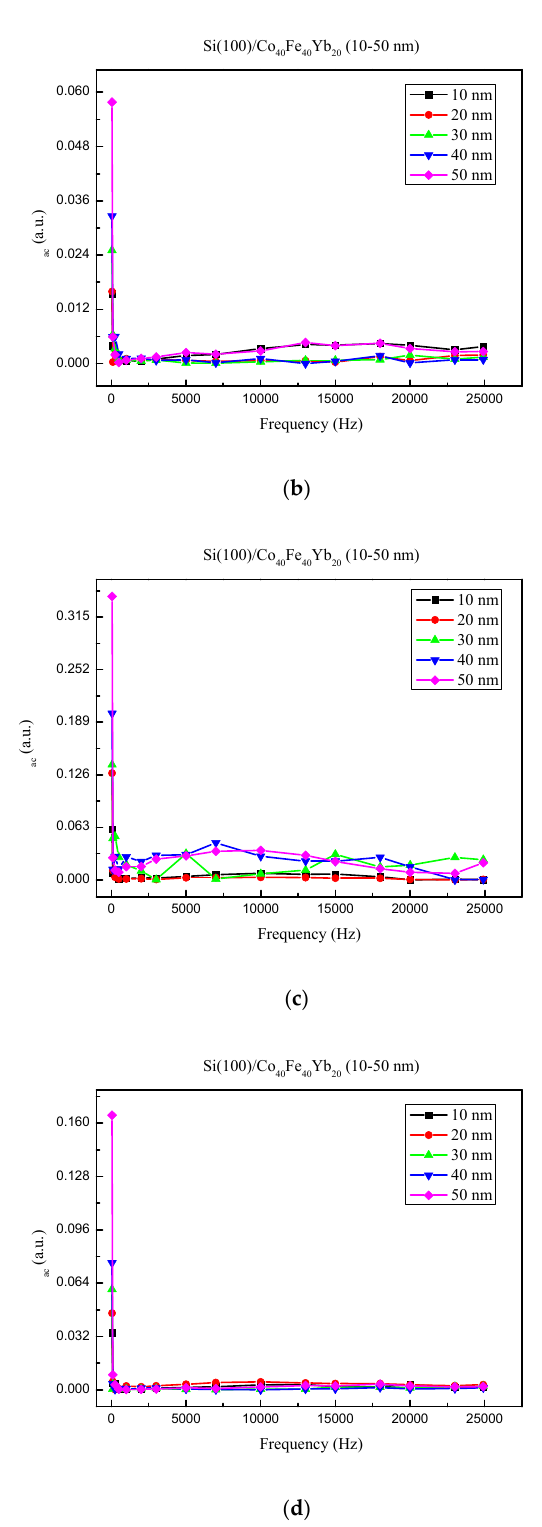
Figure 8. The frequency dependence of alternate-current magnetic susceptibility ( χ ac ) from 50 to 25,000 Hz. ( a ) As-deposited, ( b ) post-annealing at 100 ◦ C, ( c ) post-annealing at 200 ◦ C, and ( d ) post- annealing at 300 ◦